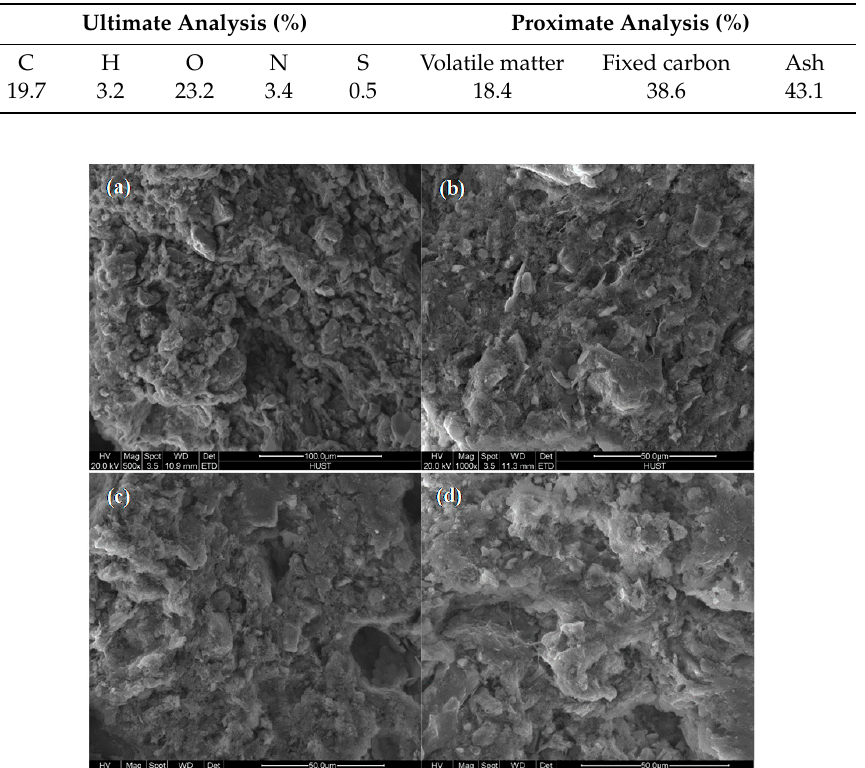
Figure 2. SEM images of residue char. Magnification: 500 × ( a ), 1000 × ( b, c ) and 1200 × ( d ). Table 1. Ultimate and proximate analysis of activated sludge.